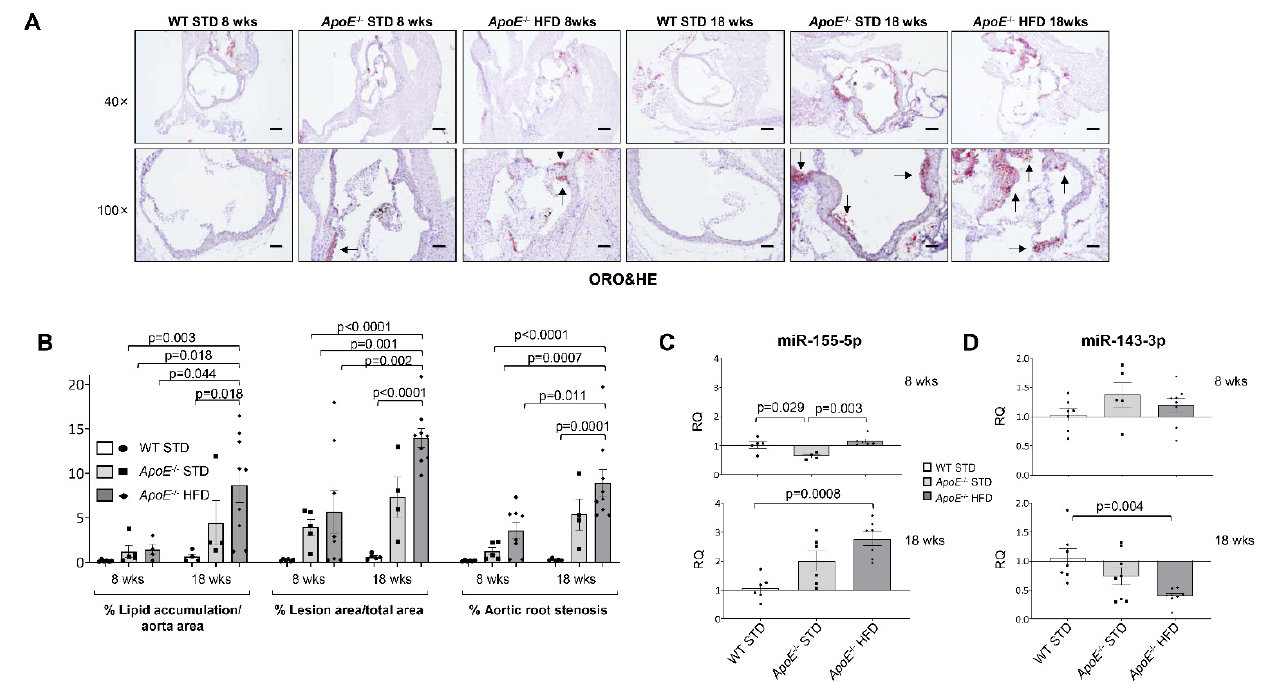
Figure 1. miR-155-5p and miR-143-3p expression in the aorta of the mouse model of atherosclerosis. ( A ) Representative images of the Oil Red O staining from the aortic roots of the six groups of experimental mouse model of atherosclerosis. Magnification 40 × (scale bar = 200 µ m); magnification 100× (scale bar = 100 µm). The black arrows point out the lipid depots in the aortic roots. ( B ) Quantifica- tion of the percentage of lipid accumulation, lesion area and stenosis of aortic root from the mouse model. WT STD 8 wks ( n = 6); ApoE − / − STD 8 wks ( n = 5); ApoE − / − HFD 8 wks ( n = 4); WT STD 18 wks ( n = 4); ApoE − / − STD 18 wks ( n = 4); ApoE − / − HFD 18 wks ( n = 9). Relative expression of miR-155-5p ( C ) and miR-143-3p ( D ) in the aorta of the three experimental groups at 8 ( upper graphics) and 18 weeks ( lower graphics) of diet was measured by qPCR. Amplification of miR-191-5p was used in the same reaction of all samples as an internal control. WT = Wild type group; STD = standard type diet; ApoE − / − = ApoE deficient mice; HFD = high-fat diet; wks = weeks. qPCR miR-155-5p: WT STD 8 wks ( n = 5); ApoE − / − STD 8 wks ( n = 4); ApoE − / − HFD 8 wks ( n = 6); WT